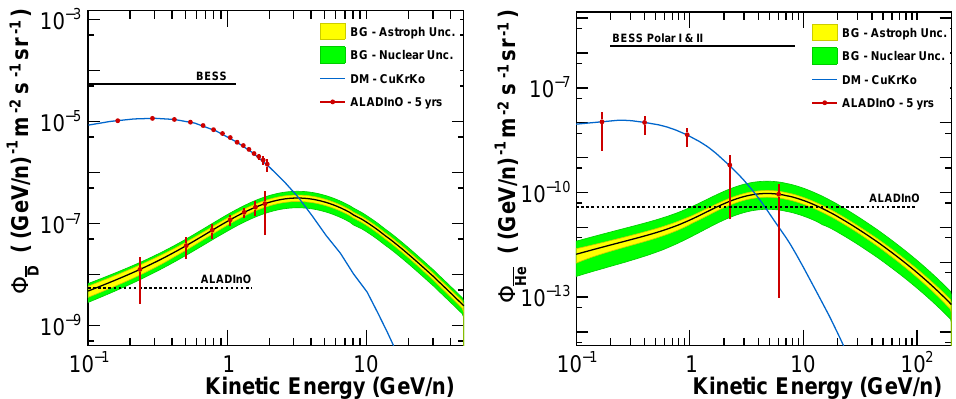
Figure 6. Expected measurement by ALADInO (red points) for the flux of D ( left ) and 3 He (( right ) as a function of kinetic energy per nucleon, in the scenarios of DM models (blue lines) consistent with available antiproton data[81,112] and astrophysical background with its uncertainties[113]. The best current upper limits are also shown[114,115]. Antideuteron searches are and will be performed by AMS-02 and GAPS during the coming years. These instruments combined will leave untested a significant region of parameter space of DM models. The dotted lines show the ALADInO sensitivity level, for 5 years of exposure, over its optimal range of detection. The ALADInO measurements for the flux of 3 He in case of astrophysical background only are not shown since the 3 He flux would be approximately compatible with the ALADInO sensitivity. Figure readapted from [96] under license CC BY